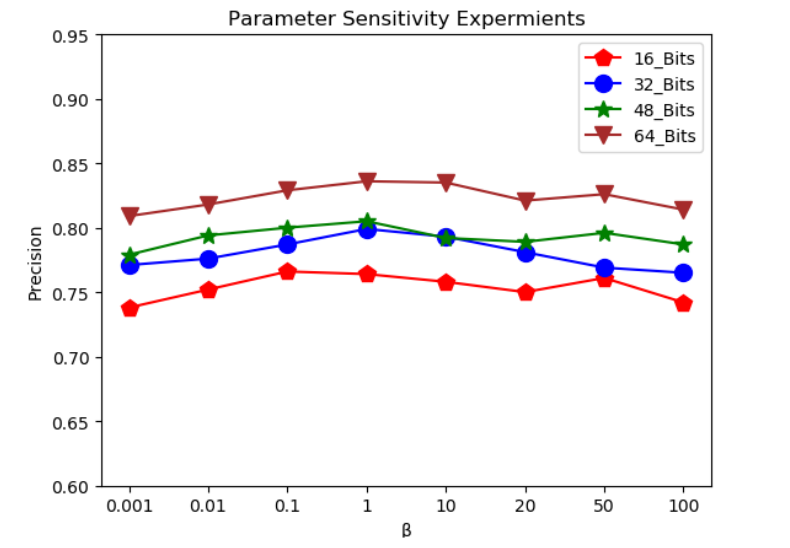
Figure 6. Parameter sensitivity curves of ADMTH to β